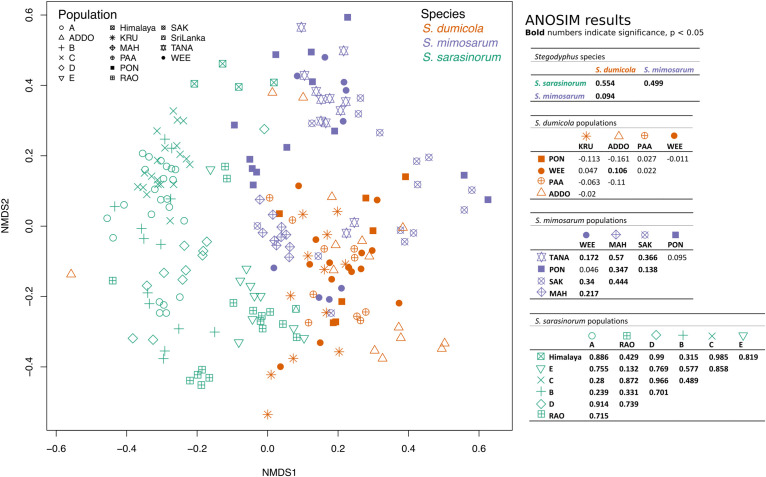
Non-metric multidimensional scaling (NMDS) ordination of spider microbiomes based on Bray–Curtis dissimilarities (with subsampled data). Each point is an individual spider. Orange: S. dumicola, purple; S. mimosarum, and green S. sarasinorum. Symbols denote the different populations. Stress = 0.23. The ANOSIM R metric indicates degree of difference between groups; R = 0 indicates no difference in microbiome composition between groups, R = 1 indicates a high degree of difference in microbiome composition between groups, and negative R values indicate more difference within a group than between groups. Bold numbers indicate significance (p < 0.05). The S. sarasinorum Sri Lanka population was removed from the ANOSIM analysis because it contains only one sample.